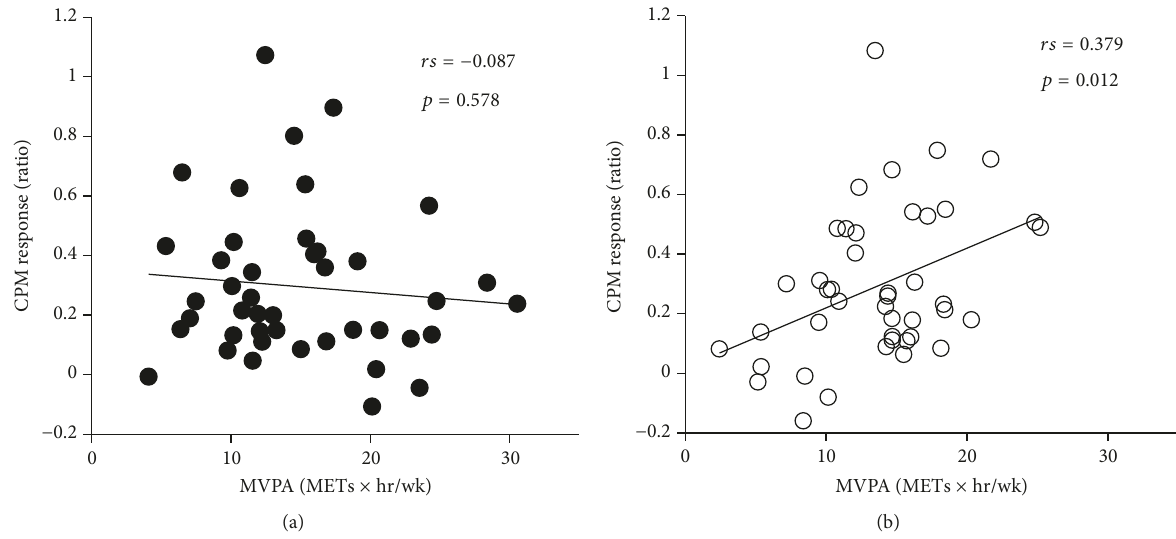
Figure 2: Correlation between CPM response and MVPA among (a) men and (b) women. CPM: conditioned pain modulation; MVPA: moderate-to-vigorous physical